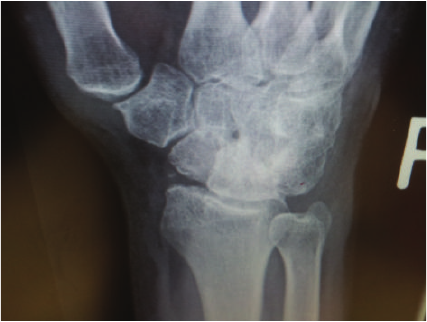
Figure 4: Postdistraction radiograph showing improved radio- carpal appearance.